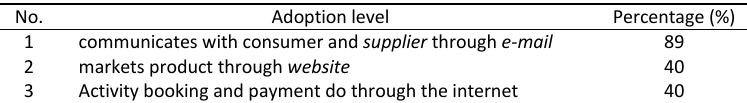
Table 4: Assessment variable adoption of E-commerce